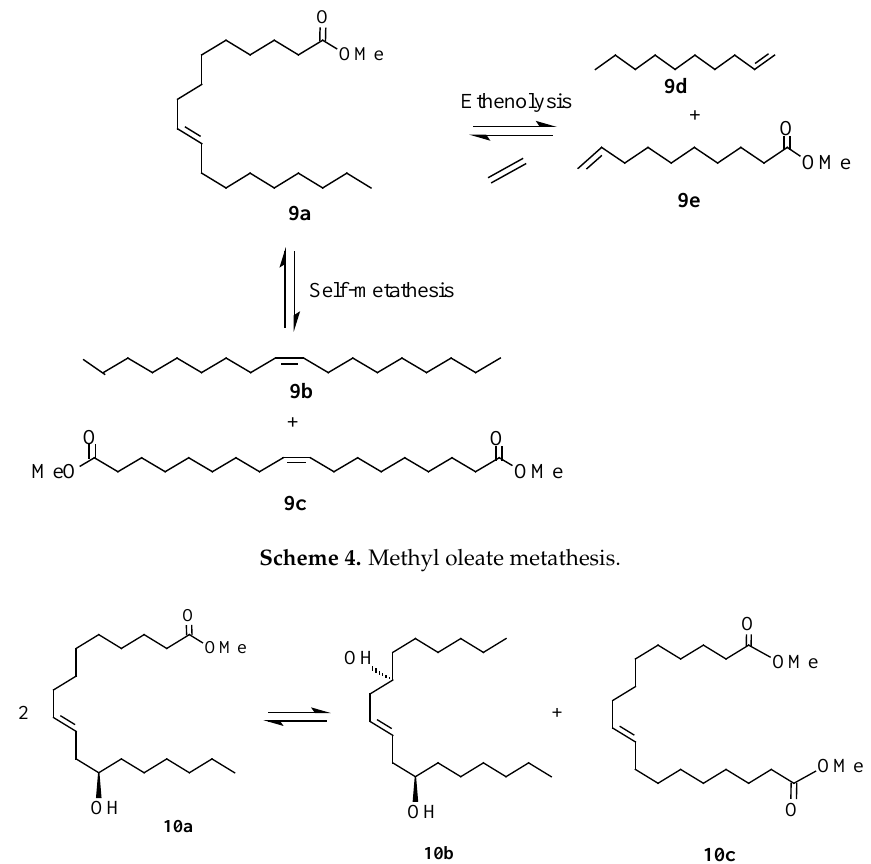
Figure 5. 1-Butyl-3-methylimidazolium ion (bmim) and 1-butyl-2,3-dimethylimidazolium ion (bdmim).